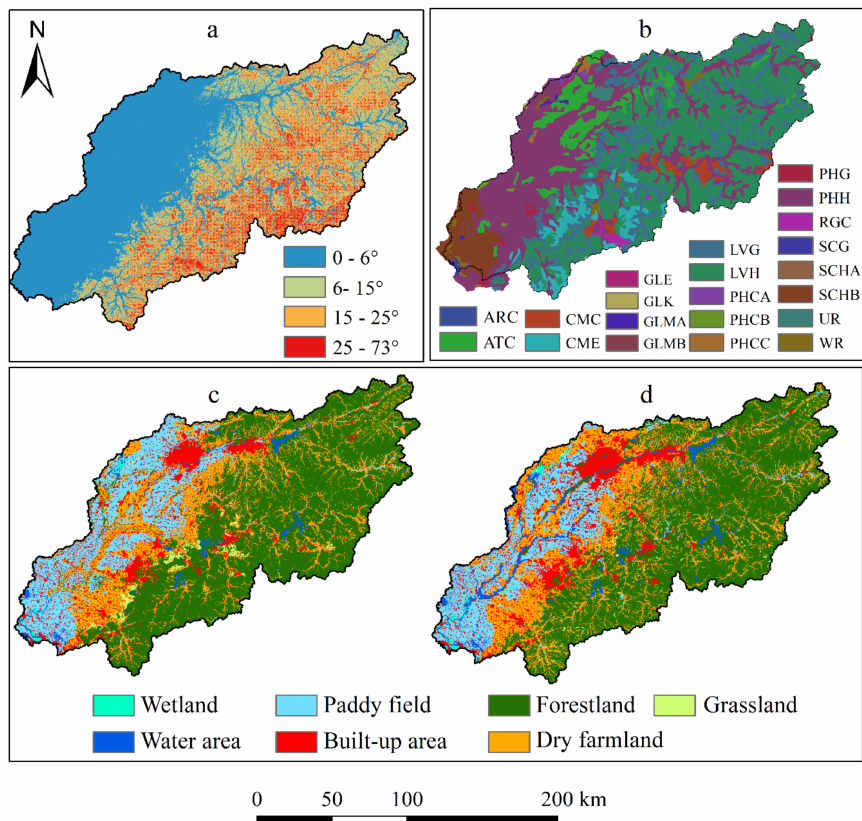
Figure 2. The data required for the Soil and Water Assessment Tool (SWAT) model. ( a ) Slope; ( b ) soil types; ( c ) 2004 land use; ( d ) 2015 land use. Calcaric Arenosols (ARC), Cumulic Anthrosols (ATC), Calcaric Cambisols (CMC), Eutric Cambisols (CME), Eutric Gleysols (GLE), Calcic Gleysols (GLK), Mollic Gleysols (GLMA and GLMB), Gleyic Luvisols (LVG), Haplic Luvisols (LVH), Calcaric Phaeozems (PHCA, PHCB, and PHCC), Gleyic Phaeozems (PHG), Haplic Phaeozems (PHH), Calcaric Regosols (RGC), Gleyic Solonchaks (SCG), Haplic Solonchaks (SCHA and SCHB), Urban, mining, etc. (UR), Water bodies